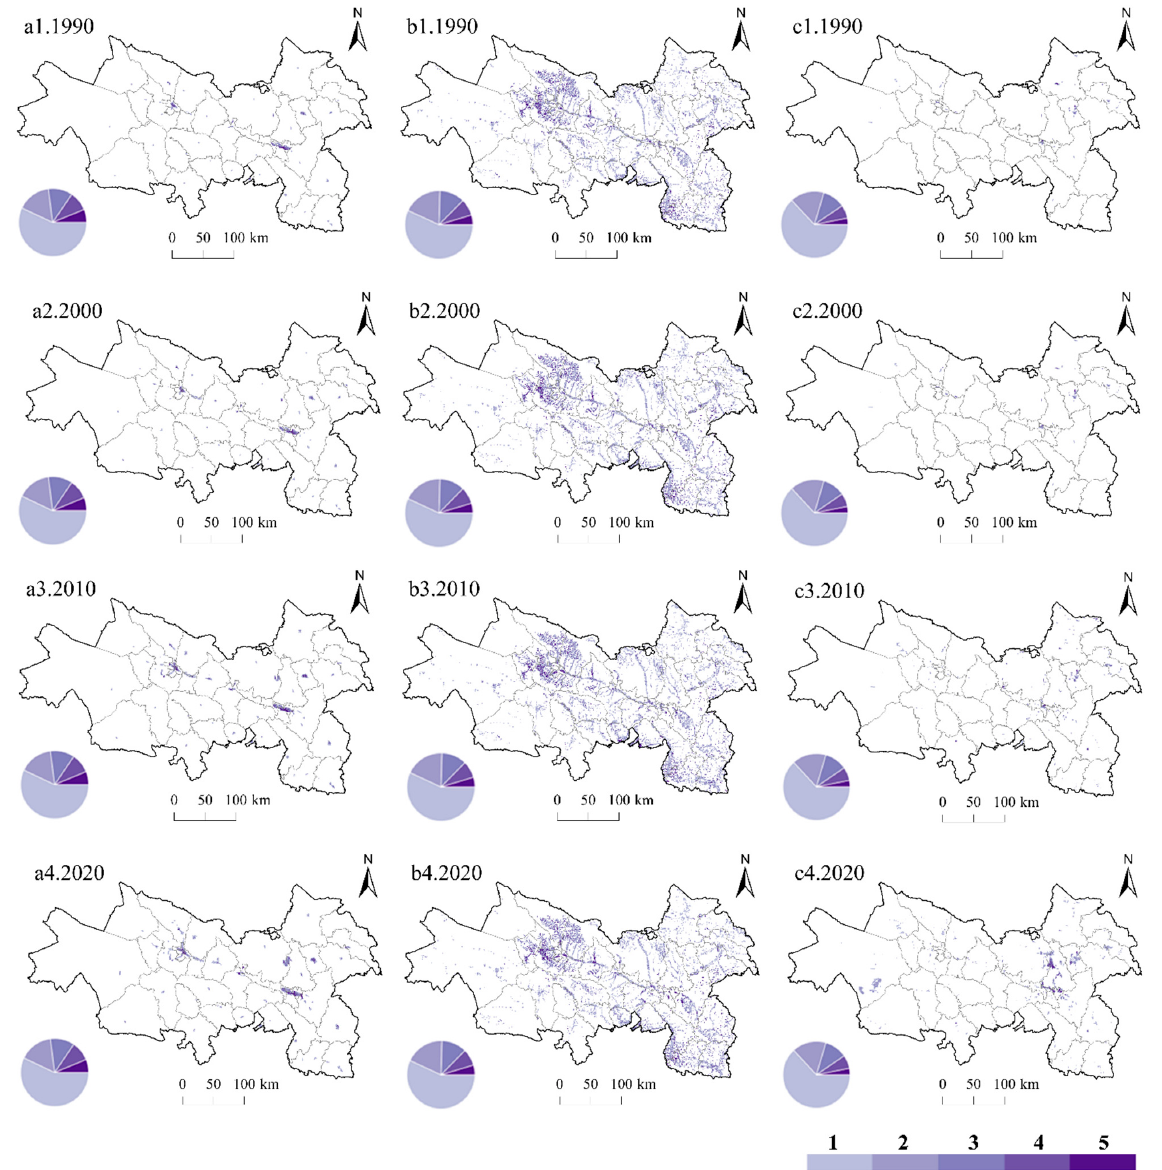
Figure 17. Grades of construction land slope shares corresponding to the three types of analyzed construction land in the LXUA from 1990 to 2020.